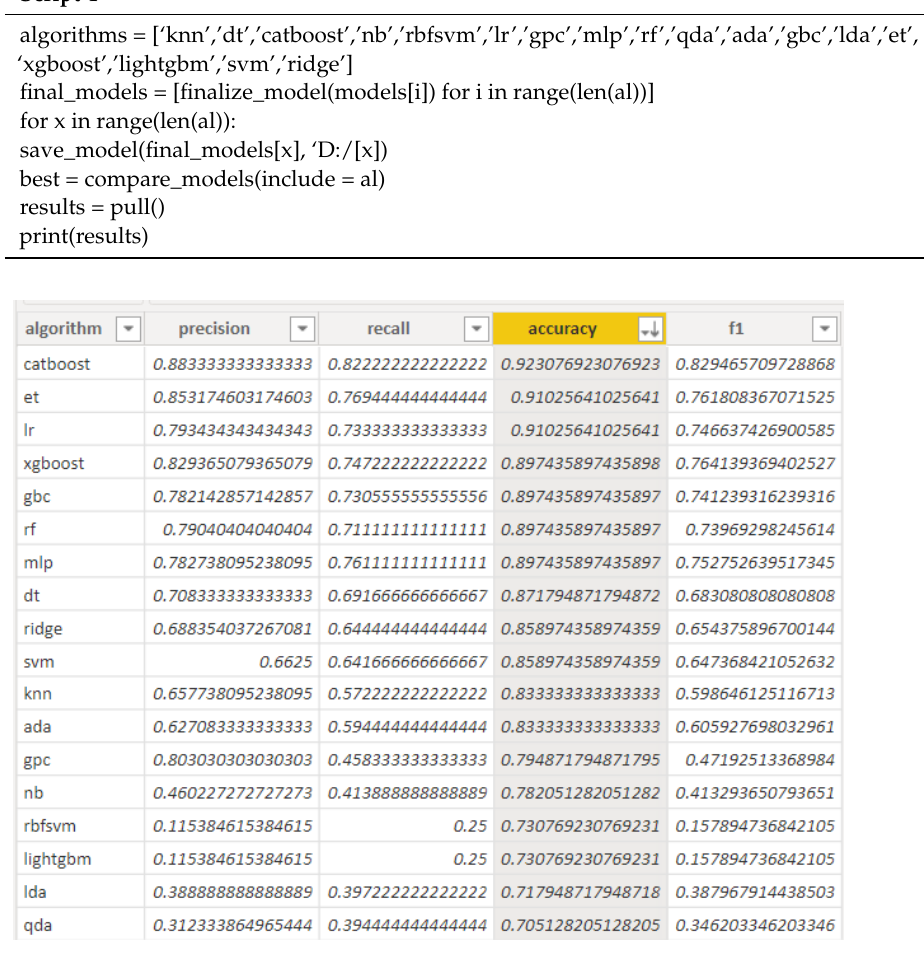
Figure 11. O45. Evaluation metrics synthesis.